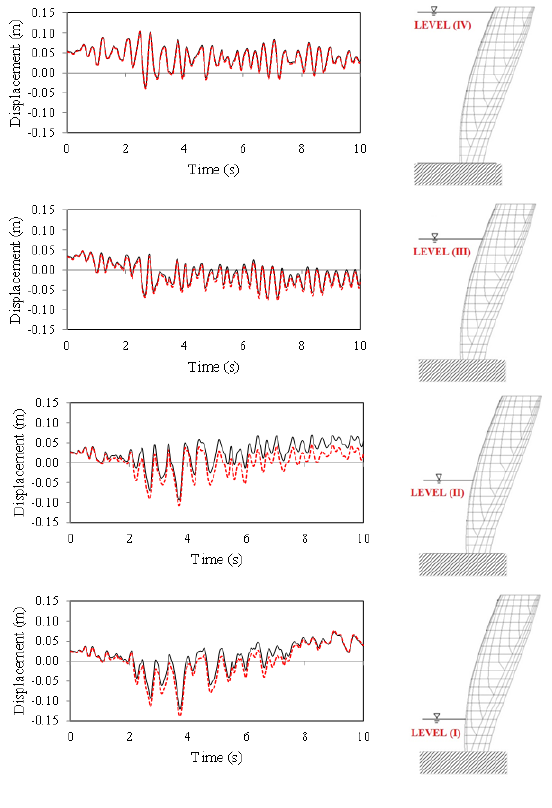
plied on upstream face of the dam body, relative move- ment of adjacent blocks leads to more displacement of the crest toward downstream direction. The Time history of the crest displacement in two coincident nodes are almost the same for the levels III and IV , showing that there is no considerable joint sliding at crest level. On the other hand, differences between displacement time-histories for the level I and especially level II reveals that the crest level experiences large joint sliding at these levels.